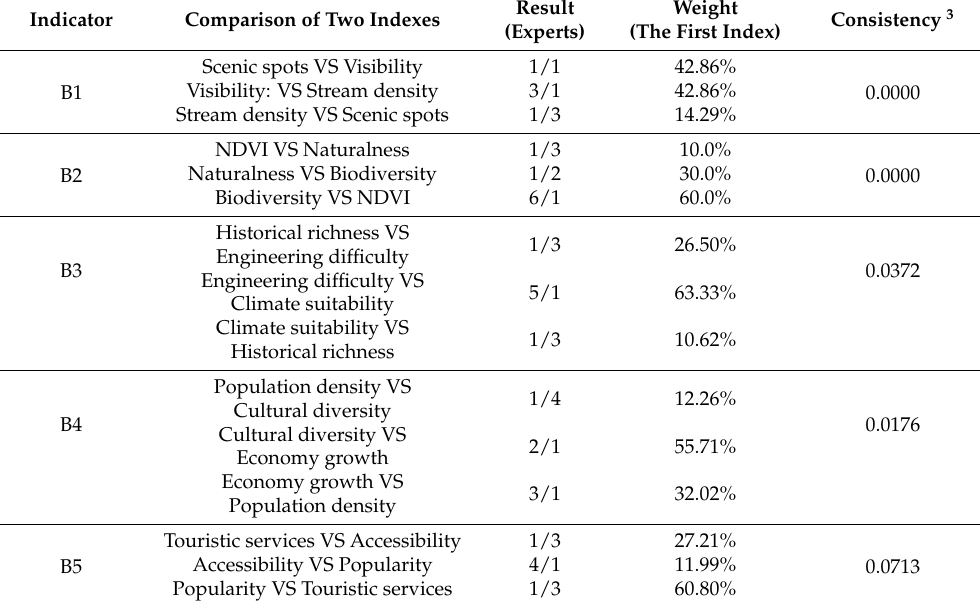
Table 4. Result of the Delphi